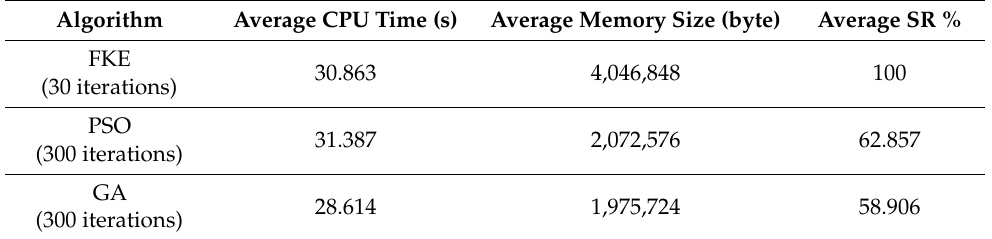
Table 11. The average CPU time, average memory size, and the average SR of FKE algorithm compared to that of the PSO and